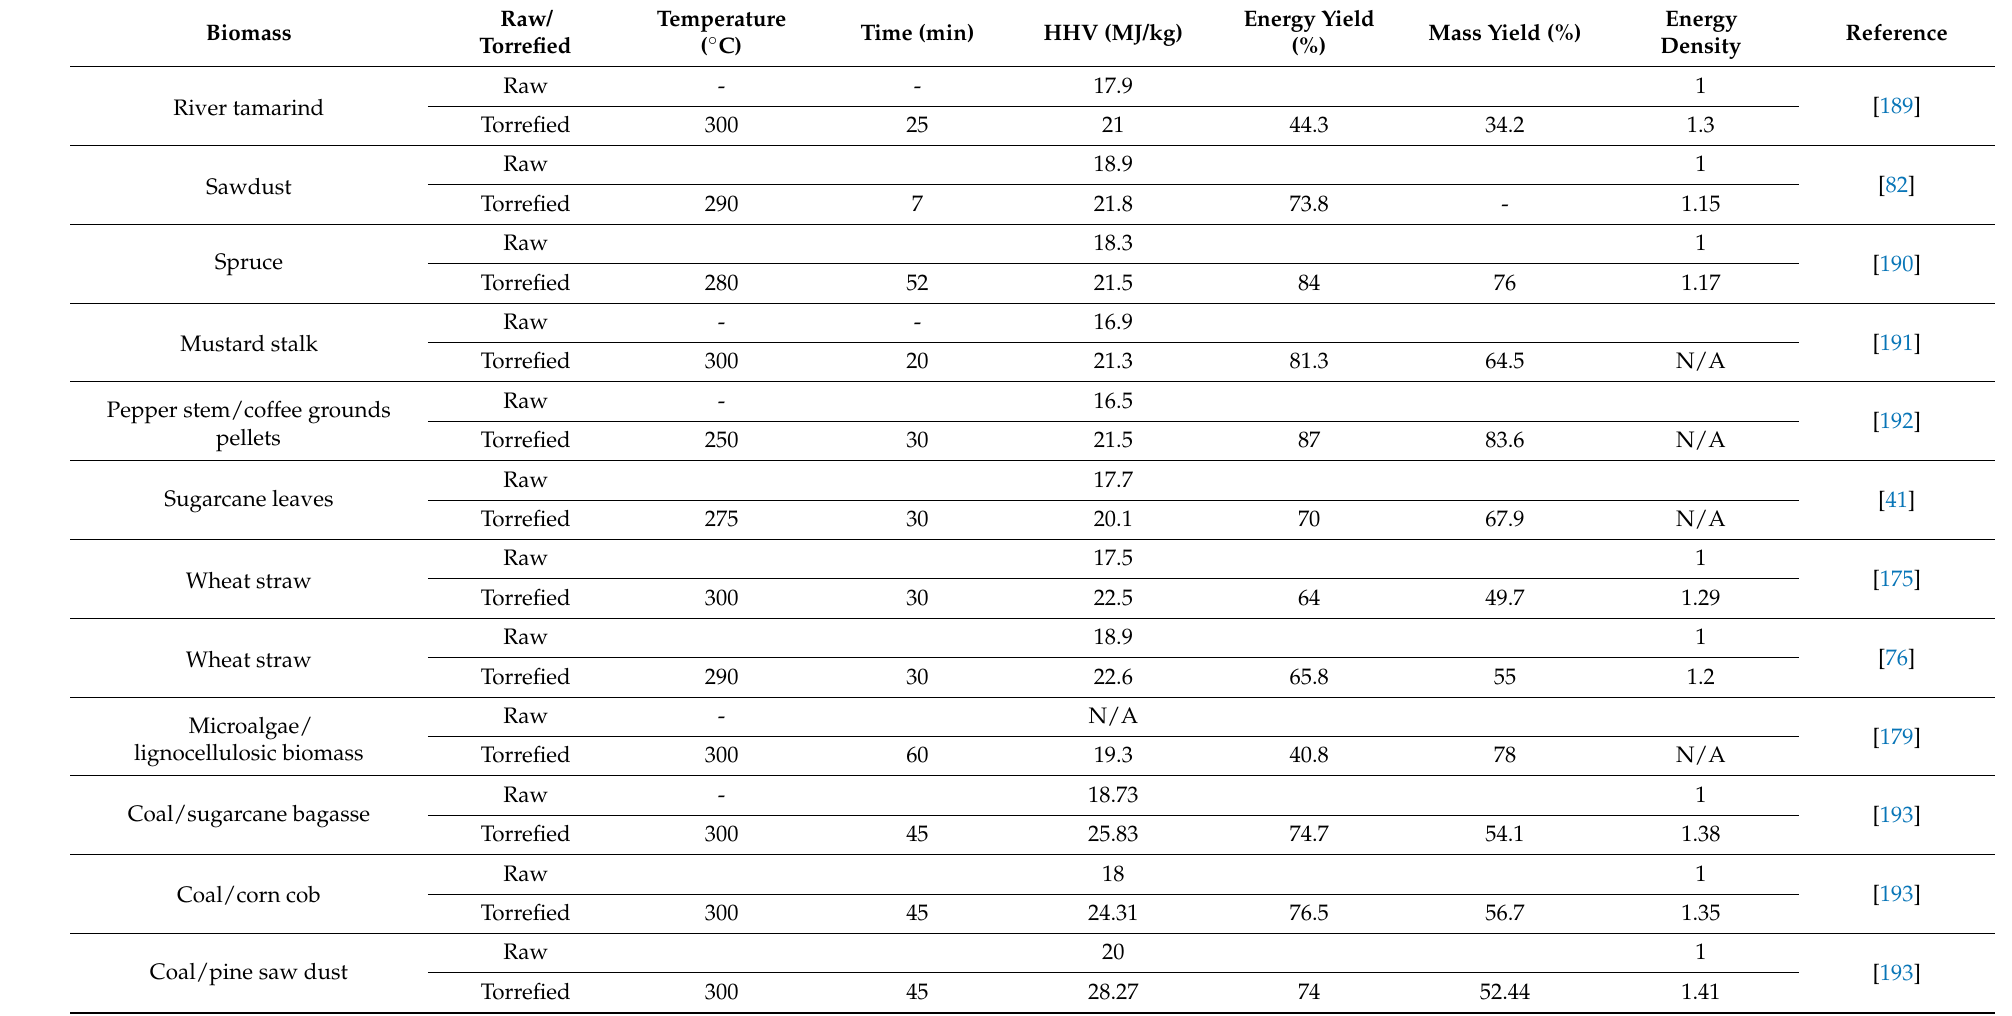
Energy Mass Yield (%) Density